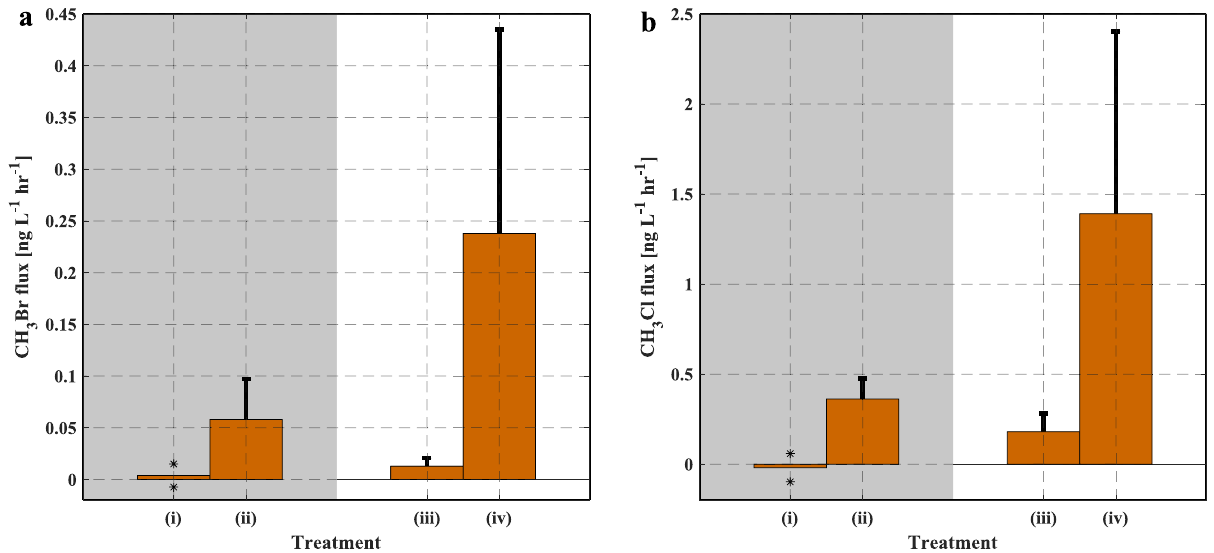
Fig. 4 Methyl halide fl uxes from seawater samples under different treatments. a Methyl bromide (CH 3 Br) and b methyl chloride (CH 3 Cl) fl uxes from the ocean water under four treatments. (i) seawater incubated under dark conditions ( n = 2); (ii) seawater with Cu(II) amendment incubated under dark condition ( n = 4); (iii) seawater incubated under ambient sunlight ( n = 5); and (iv) seawater with Cu(II) amendment incubated under ambient sunlight ( n = 7). The bars represent the average fl uxes from replicate incubations of each treatment, and the error bars represent the standard deviations. For treatment (i), the two individual fl uxes were presented in the fi gure (*), instead of the standard deviation.